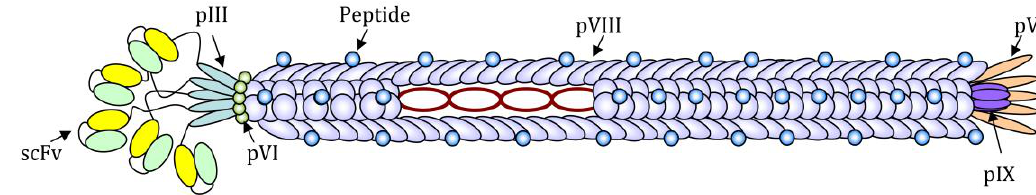
Figure 1. Schematic image of a filamentous bacteriophage nanoparticle engineered for the expression of a short antigenic peptide as a fusion with N-terminus of the pVIII protein and a single-chain antibody fragment (scFv) for the targeting, as a fusion with the N-terminus of the pIII protein. The circular single-strand DNA rich in CpG motifs can be recognized by PPR and acts as an adjuvant.